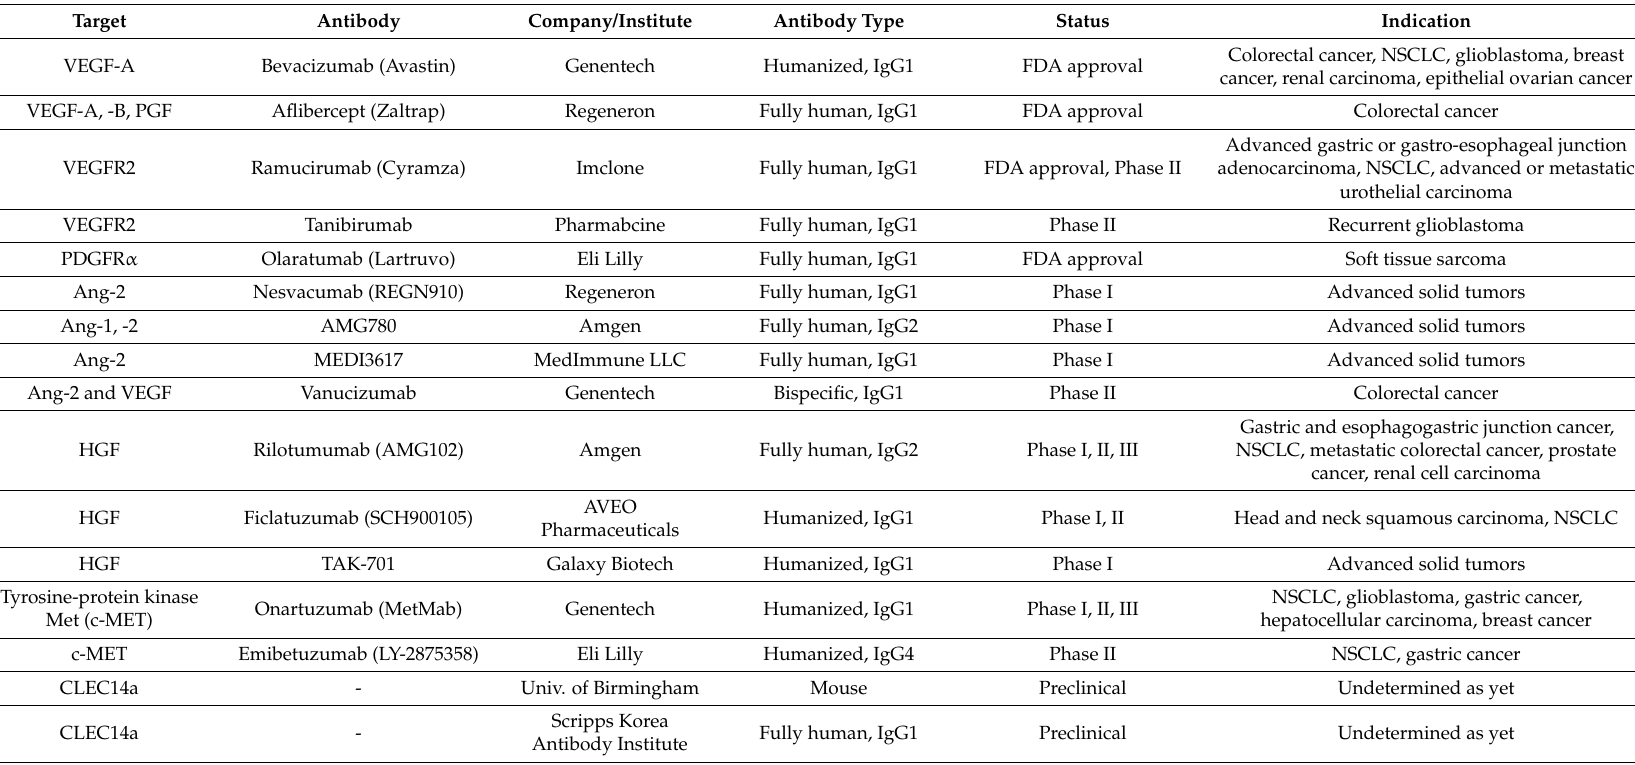
Table 1. Selected examples of monoclonal antibodies currently in clinical use and